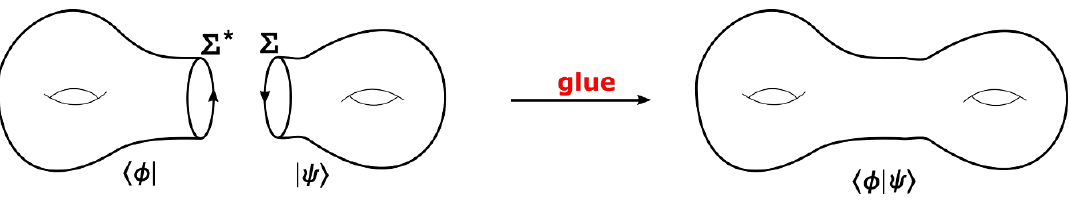
Figure 2 . Two manifolds on left with same boundary but opposite orientation. The path integral on these manifolds give states h (cid:30) j 2 H (cid:6) (cid:3) and j i 2 H (cid:6) . The inner product h (cid:30) j i will be the partition function of manifold shown in right obtained by gluing the two manifolds along the common